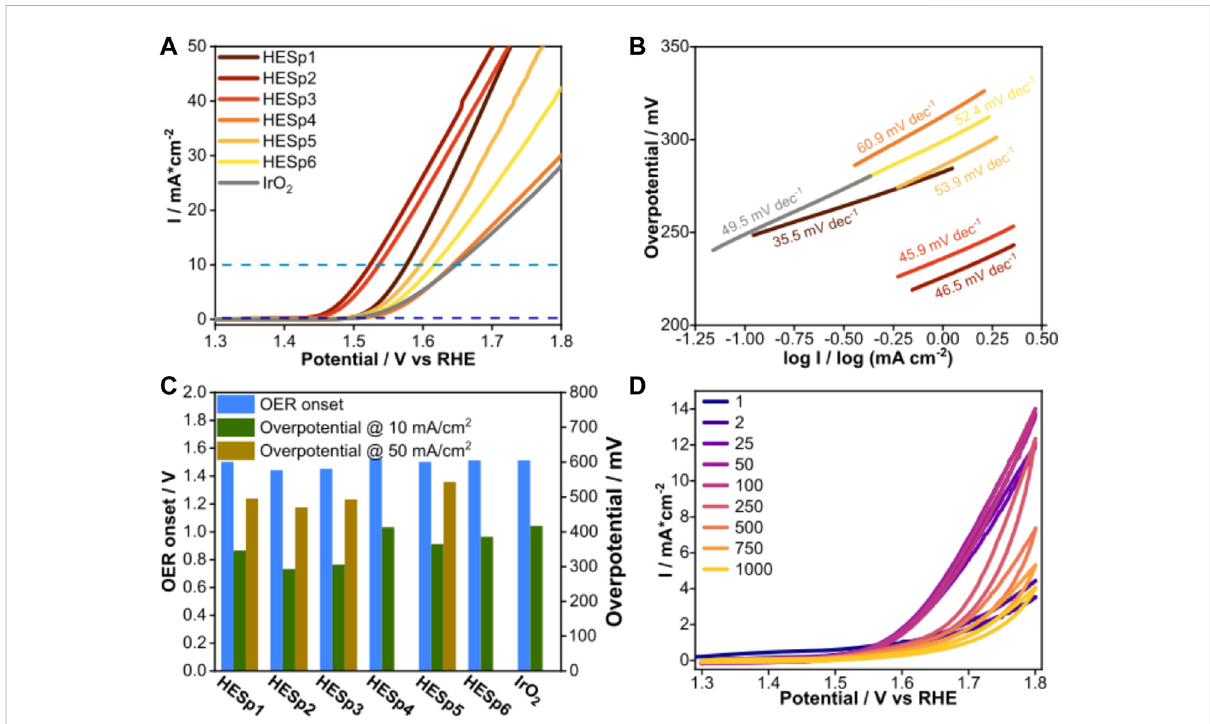
FIGURE 5 (A) LSV curves of the different HESp materials including IrO 2 during the OER in O 2 -saturated 1 M KOH, the dotted lines mark the values for the OER onset (dark blue) and overpotential at 10 mA/cm 2 (light blue). (B) Tafel slopes of the different HESp materials. (C) Comparison of the values for OER onset and overpotentials. Missing bars indicate a very large overpotential. (D) Voltammogram of HESp2 during CV after 1, 2, 25, 50, 100, 250, 500, and 1,000